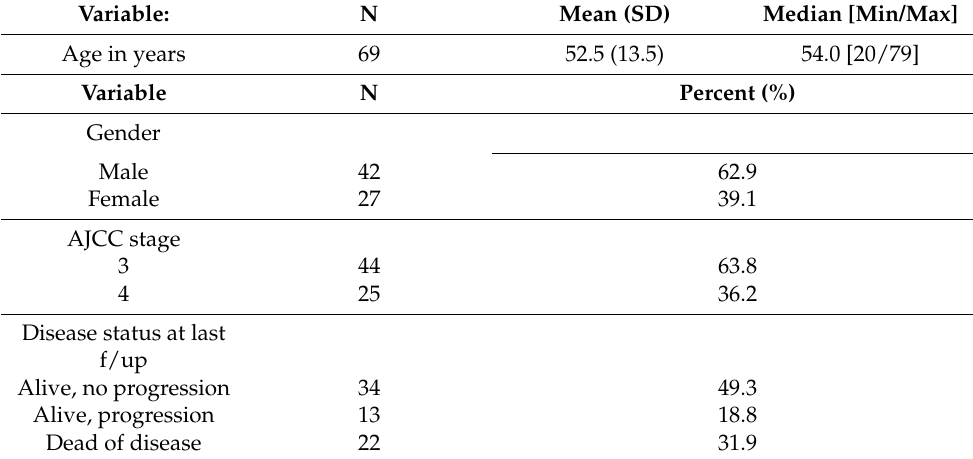
Table 1. Demographic Characteristics and Outcomes (N = 69).